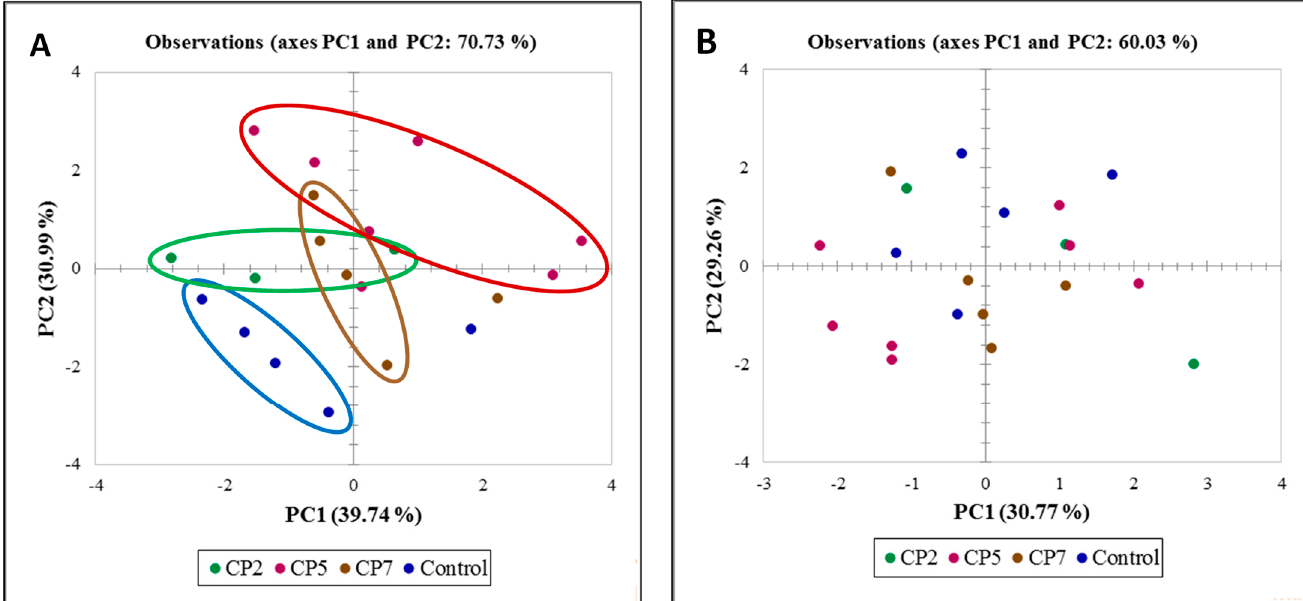
Figure 4. Biplot of principle components of the control group and treatment groups (CP2, CP5 and CP7) based on ( A ) morphometric parameters (dry leaf mass, the number of leaves, plant height) and SG parameters (the concentrations of rebaudioside A (RebA) and stevioside (Stev), total concentration of SGs (RebA+Stev), ratio RebA/Stev in stevia leaves); and ( B ) morphometric parameters (dry leaf mass, the number of leaves, plant height) and biochemical parameters (total phenolic content (TPC), total flavonoid content (TFC), antioxidant activity (AA) in stevia leaves).